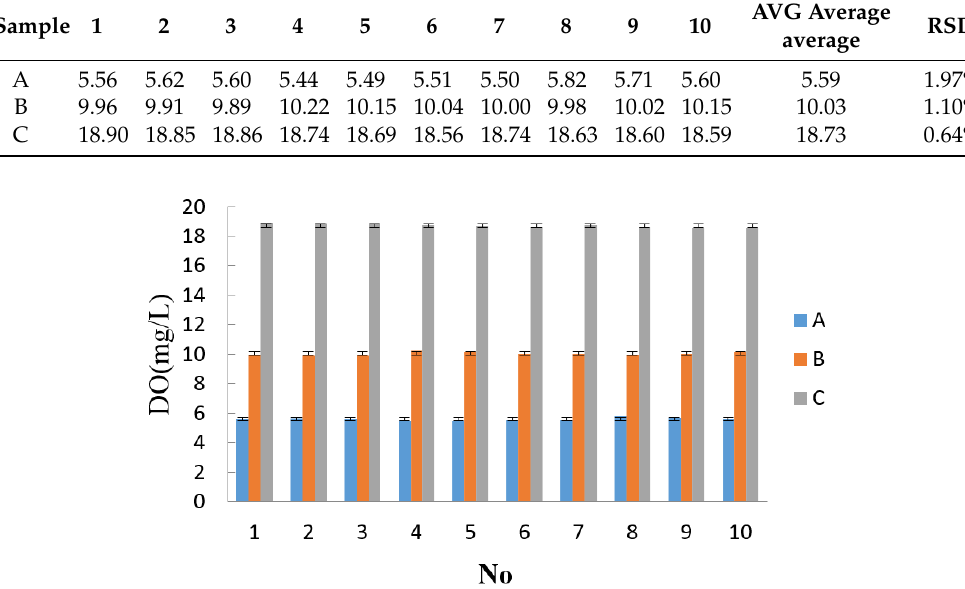
Figure 10. Precision test.